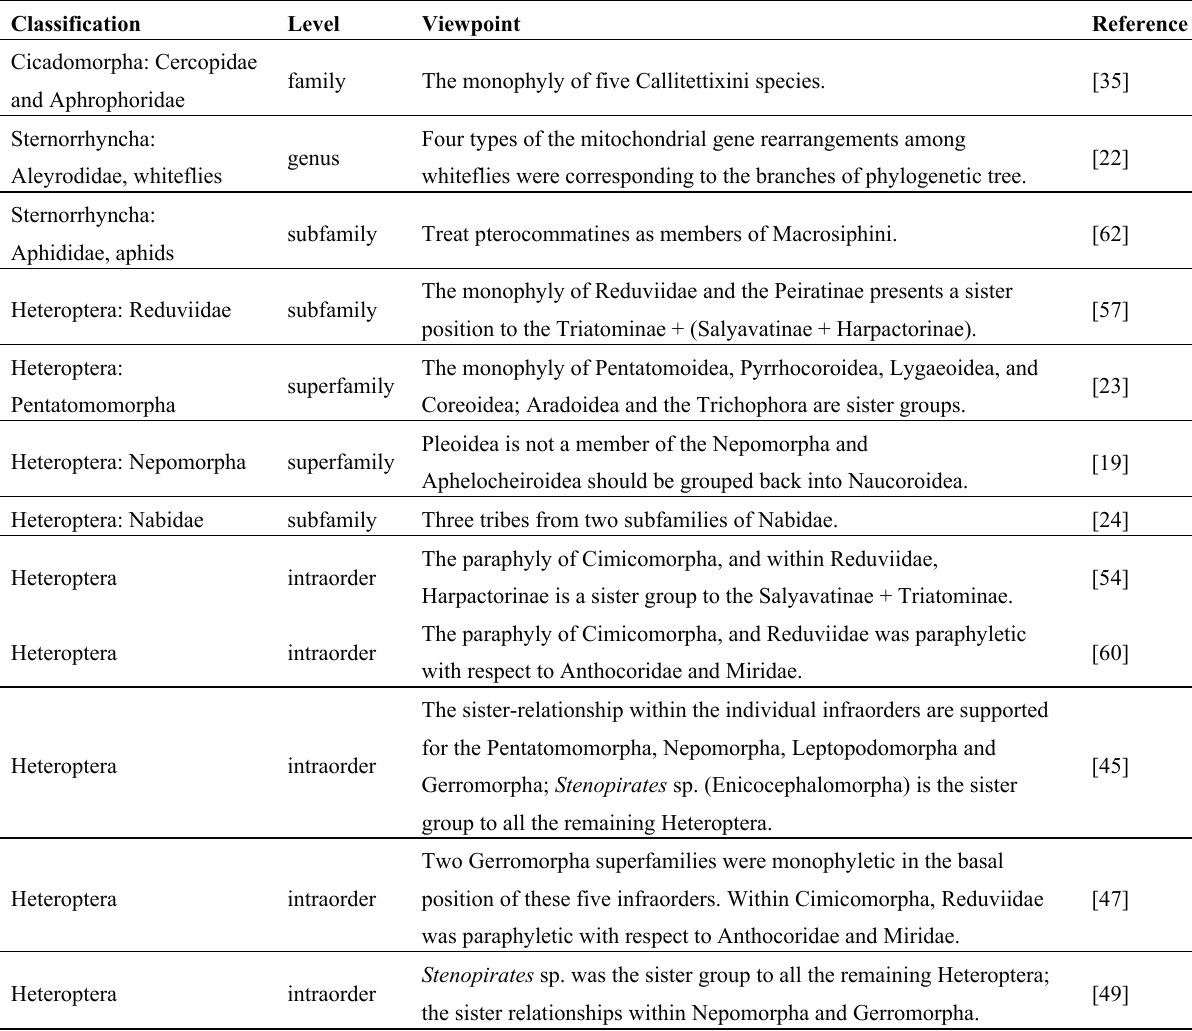
Table 4. The phylogenetic analyses under the suborder taxa of